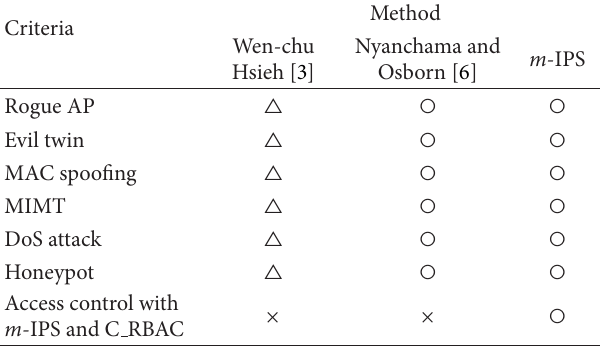
Table 4: Characteristics comparison and analysis among the exist- ing methods and the proposed